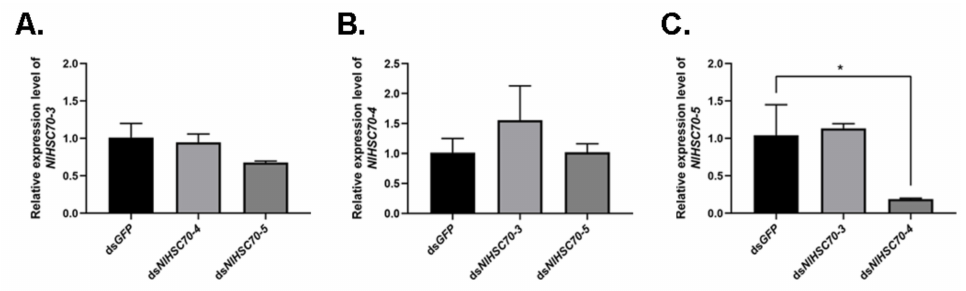
Figure 8. ( A ) The relative expression of NlHSC70-3 when NlHSC70-4 and NlHSC70-5 were knocked down. ( B ) The relative expression of NlHSC70-4 when NlHSC70-3 and NlHSC70-5 were knocked down. ( C ) The relative expression of NlHSC70-5 when NlHSC70-3 and NlHSC70-4 were knocked down. ds GFP was used as the negative control. Results are presented as mean ± SEM. * p < 0.05 (Student t